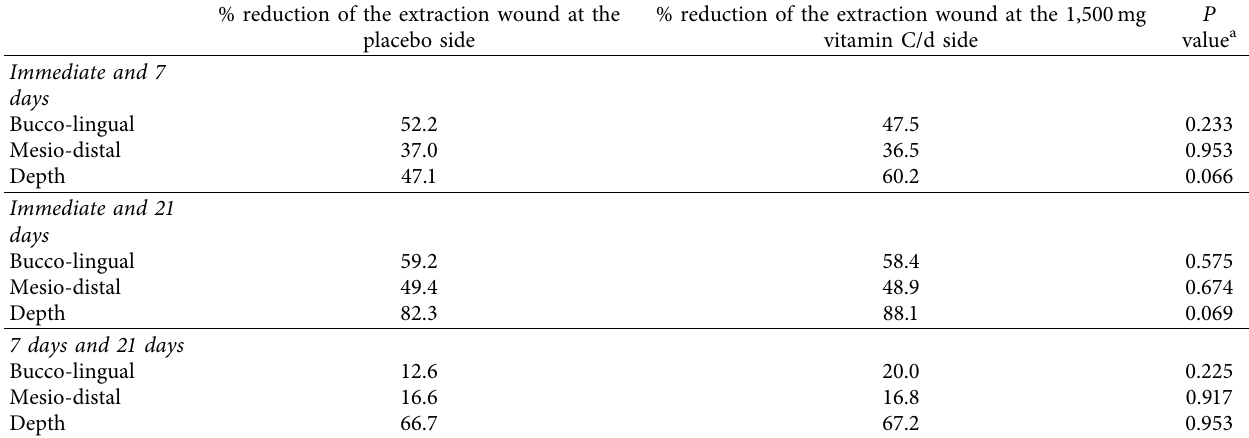
Table 2: % reduction in mean wound size between the 2 extraction sites in the P/1,500 group (placebo vs. 1,500mg vitamin C/d). % reduction of the extraction wound at the % reduction of the extraction wound at the 1,500mg placebo side